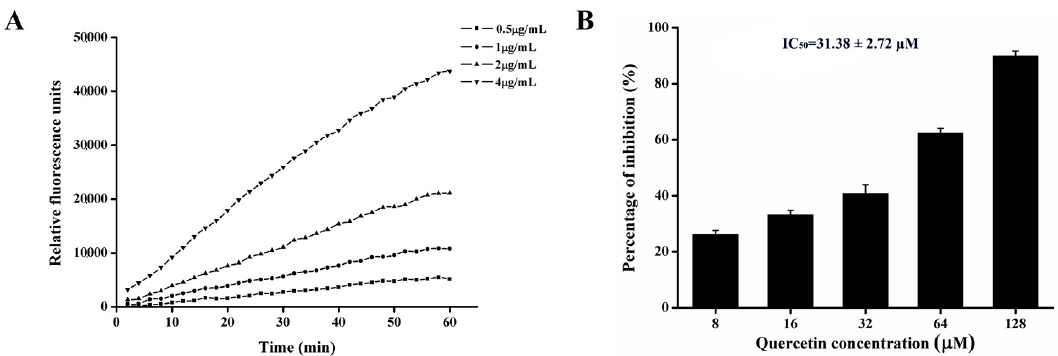
Figure 8. The inhibitory e ff ect of quercetin on PEDV 3CL pro . ( A ) Analysis of the activity of the purified PEDV 3CL pro in a fluorescence resonance energy transfer (FRET) assay. ( B ) E ff ect of quercetin on the activity of PEDV 3CL pro in a FRET assay. IC 50 was determined using SPSS 17.0 software. Data are shown as the means ± SD of three independent experiments, with the error bars representing the standard